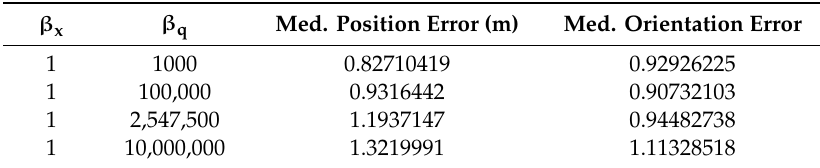
Fine-tuning error of the exponential-based model with various orientation scaling coe ffi cients, β q